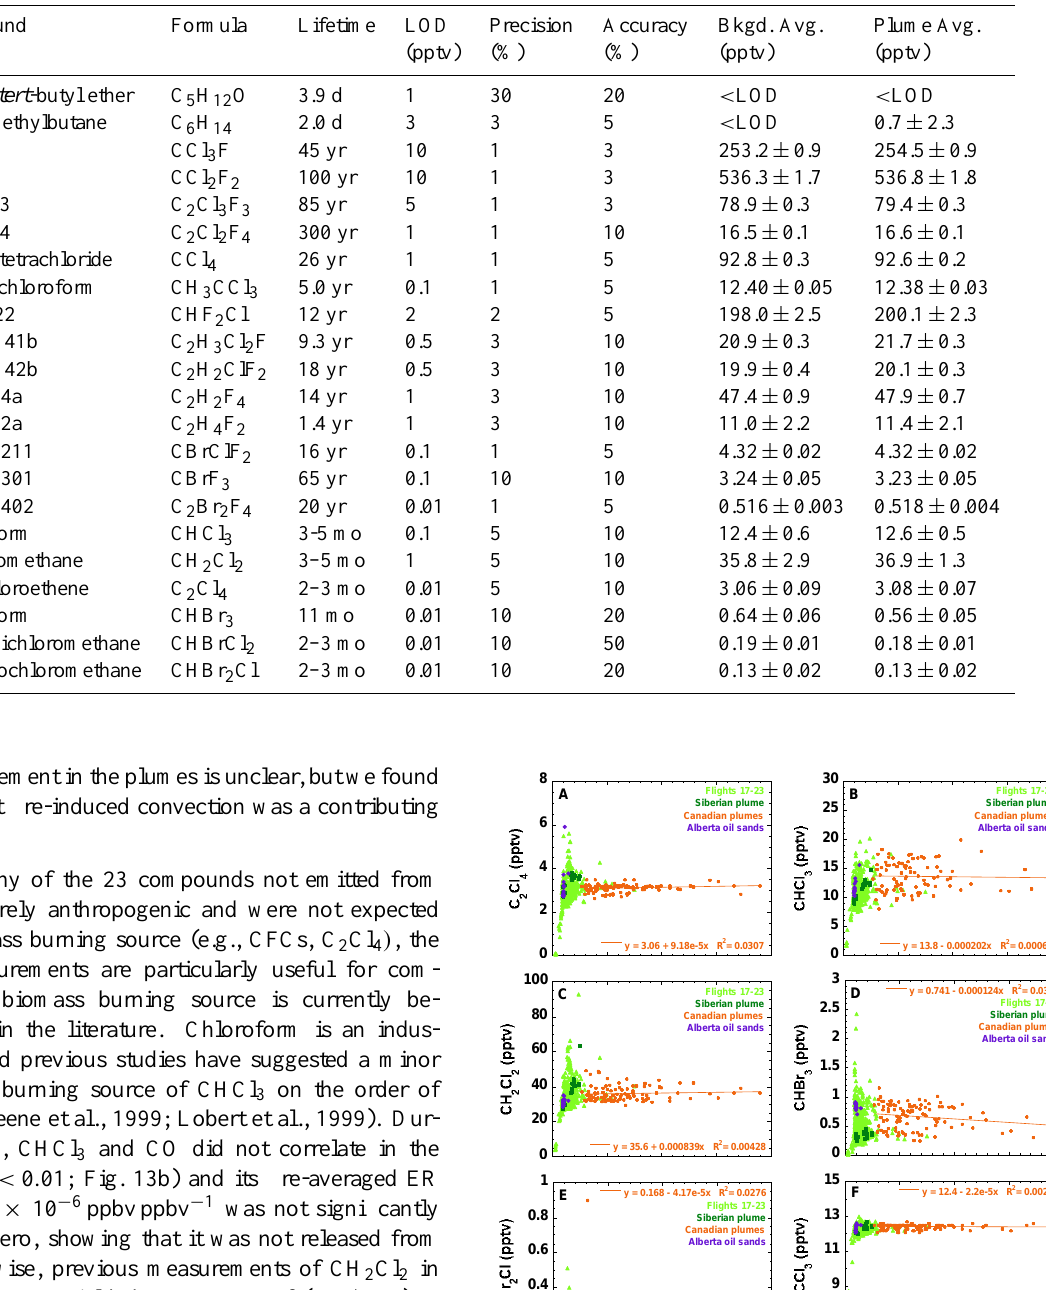
Table 4. Analytical details and measurement statistics for 23 NMVOCs that were not statistically enhanced in five boreal forest fire plumes as compared to background measurements made during ARCTAS-B. “Plume avg.” and “Bkgd. avg.” are as in Table 1.